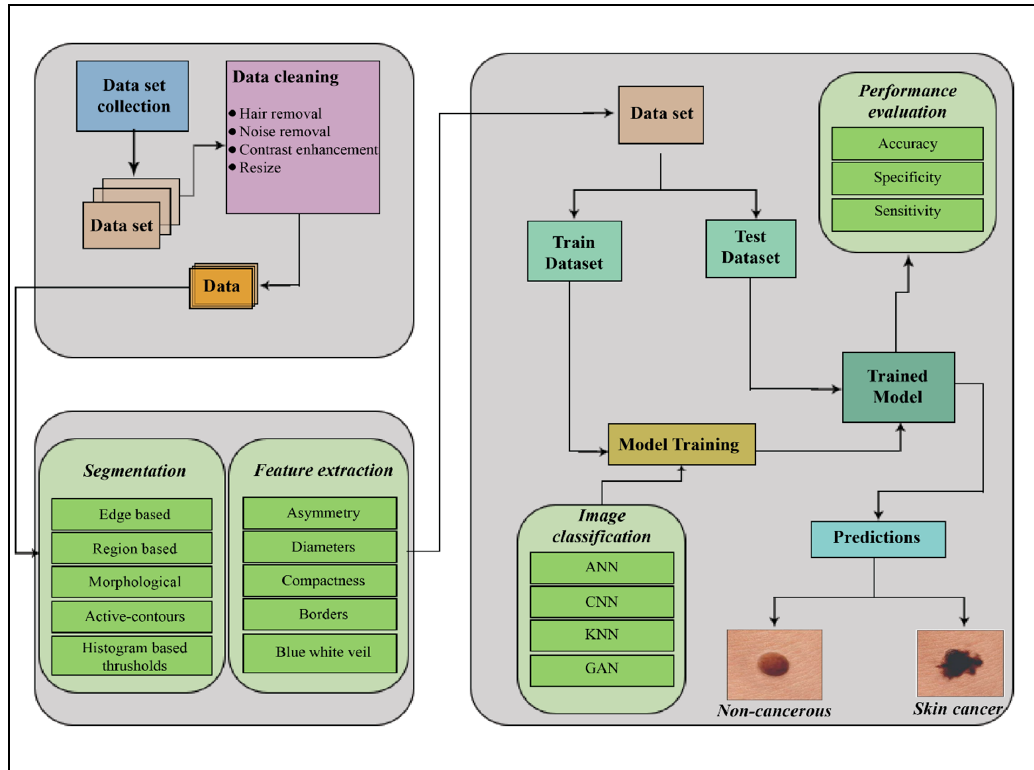
Figure 1. The process of skin cancer detection. ANN = Artificial neural network; CNN = Convolutional neural network; KNN = Kohonen self-organizing neural network; GAN = Generative adversarial neural network.